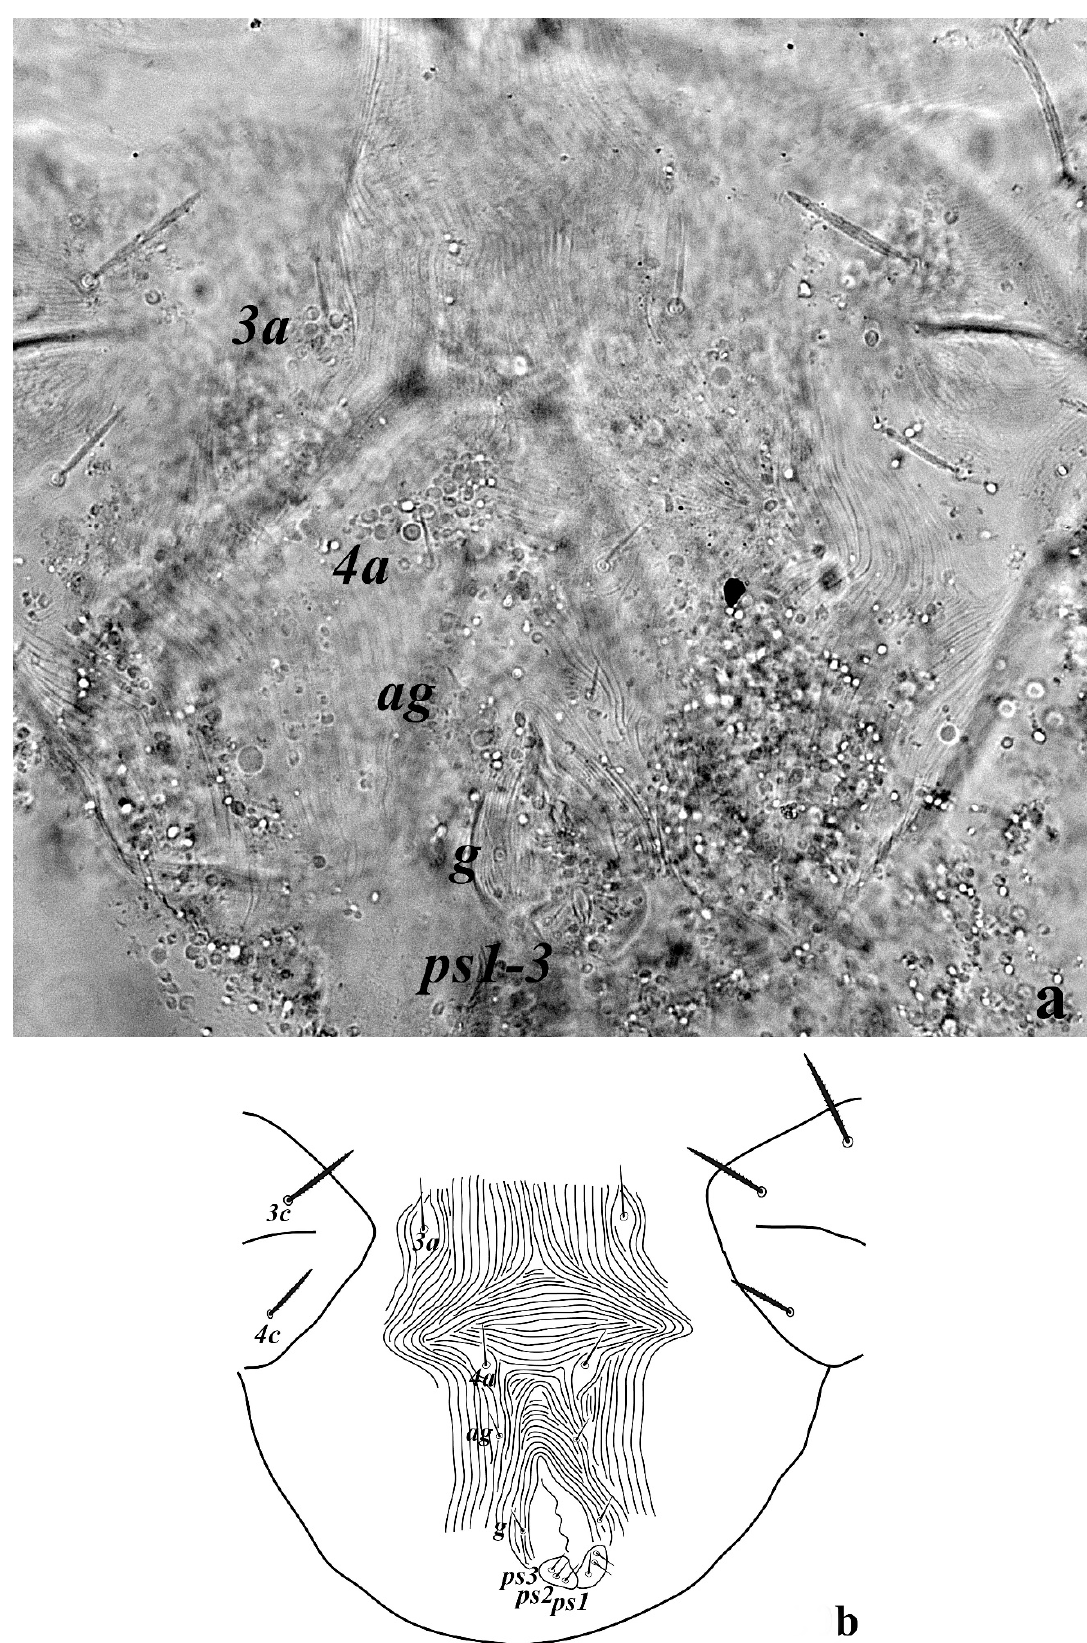
Figure 30 . ( a , b ) Tycherobius emadi . Female. Venter. Figure 30. ( a , b ) Tycherobius emadi . Female.